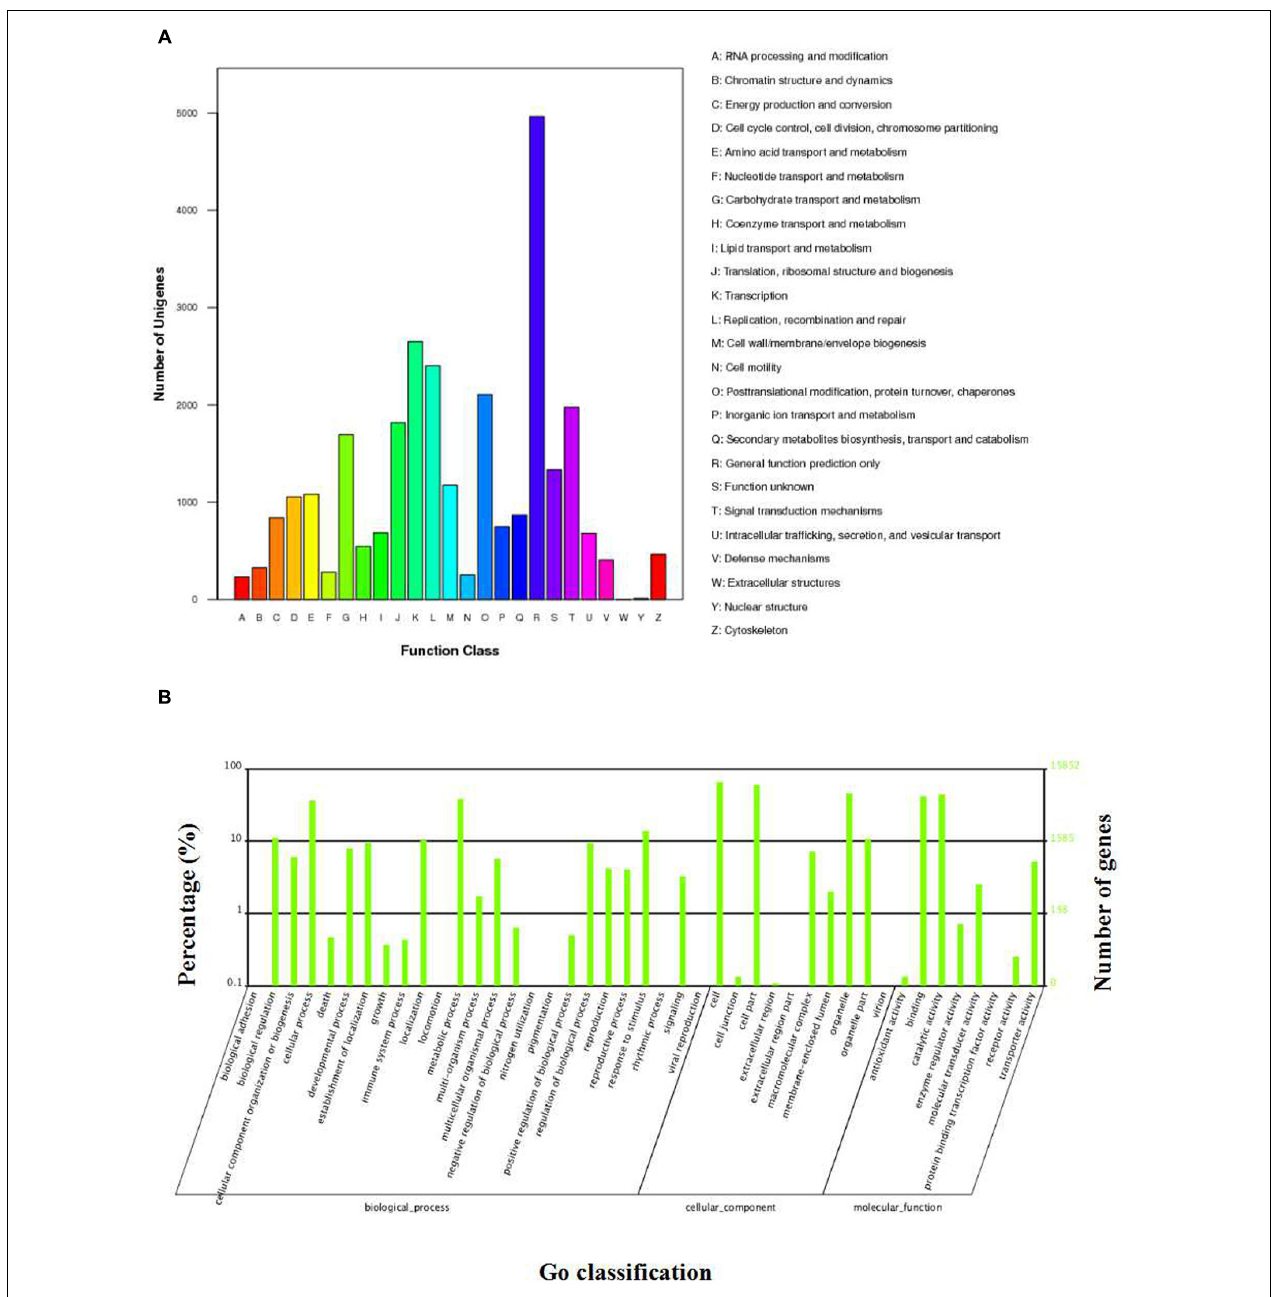
FIGURE 3 | GO and COG classification of S. cruentus unigenes. (A) COG classification. (B) GO